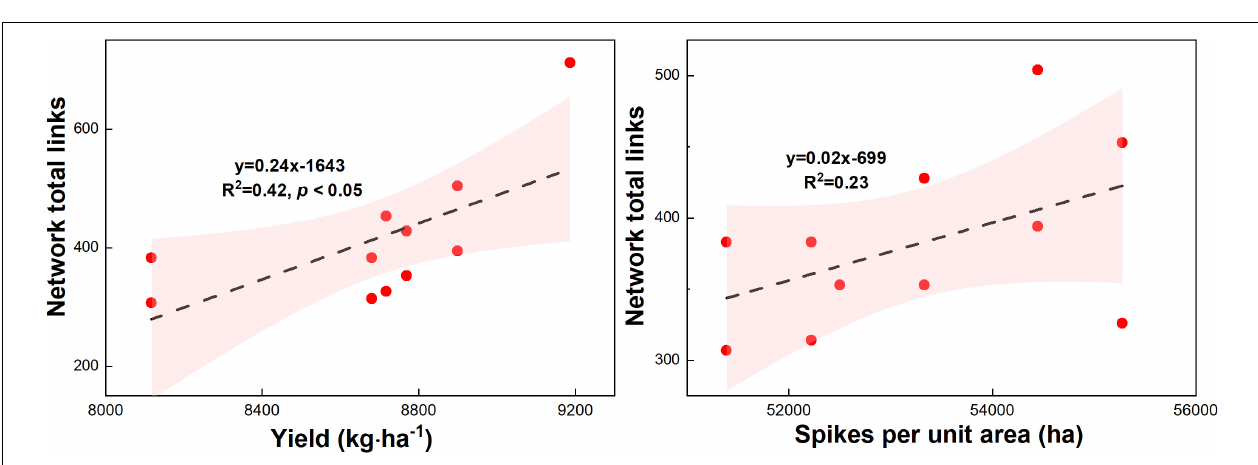
FIGURE 7 | Overview of bacterial networks in the rhizosphere soil at the maize physiological maturity stage under different N fertilizer treatments (including CT, U, S, SU3, SU5, and SU7), with node size proportional to node connectivity. Node color represents various phylogenetic